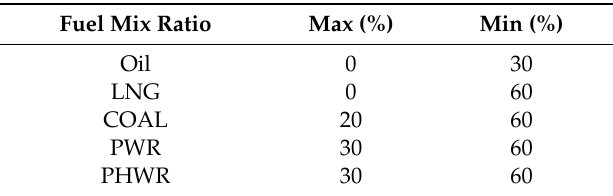
Table 8. A fuel mix ratio of units used in planning.